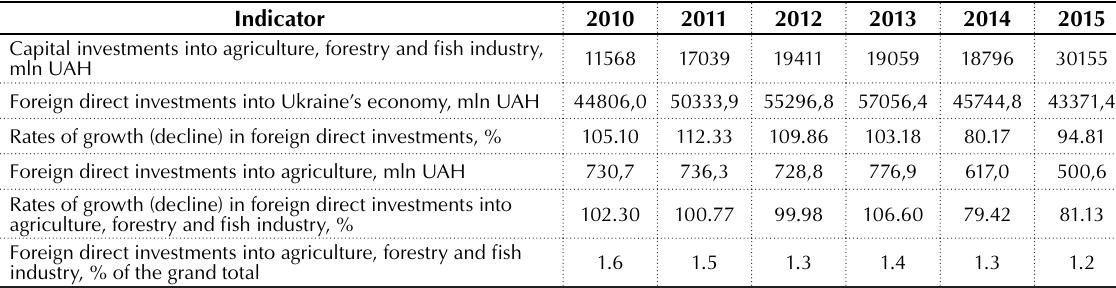
Table 1. Foreign direct investments into the agriculture of Ukraine in 2010–20015